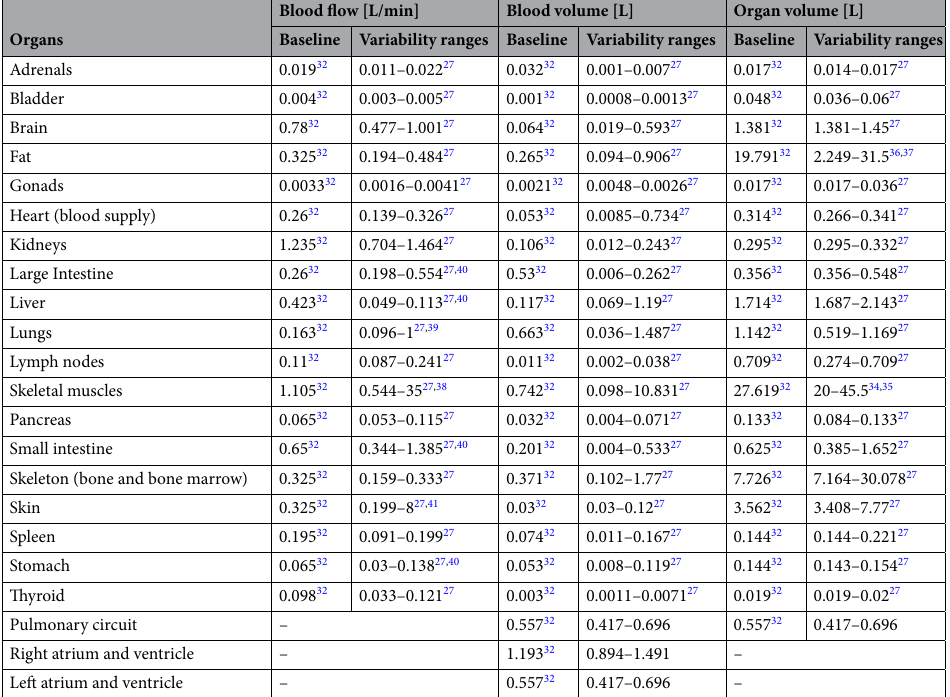
Table 2. Human anatomical parameter values and variability ranges used for the model parameterisation. The baseline parameter values come from the International Commission on Radiological Protection (ICRP) compilations 32,33 . The variability ranges were based on the parameter value selection made by Brown et al. 27 and additional selected literature sources 34–41 . Note that liver row does not include the portal vein, and the pulmonary circuit is listed separately from the lung blood supply parameters. Also note that the parameterisation for the heart chambers includes the blood volume of major blood vessels—superior and inferior vena cavae (for the right ventricle and atrium) and aorta (for the left atrium and ventricle), while the skeleton parameterisation corresponds to an amalgam of bone and bone marrow (see Supplementary Material for more